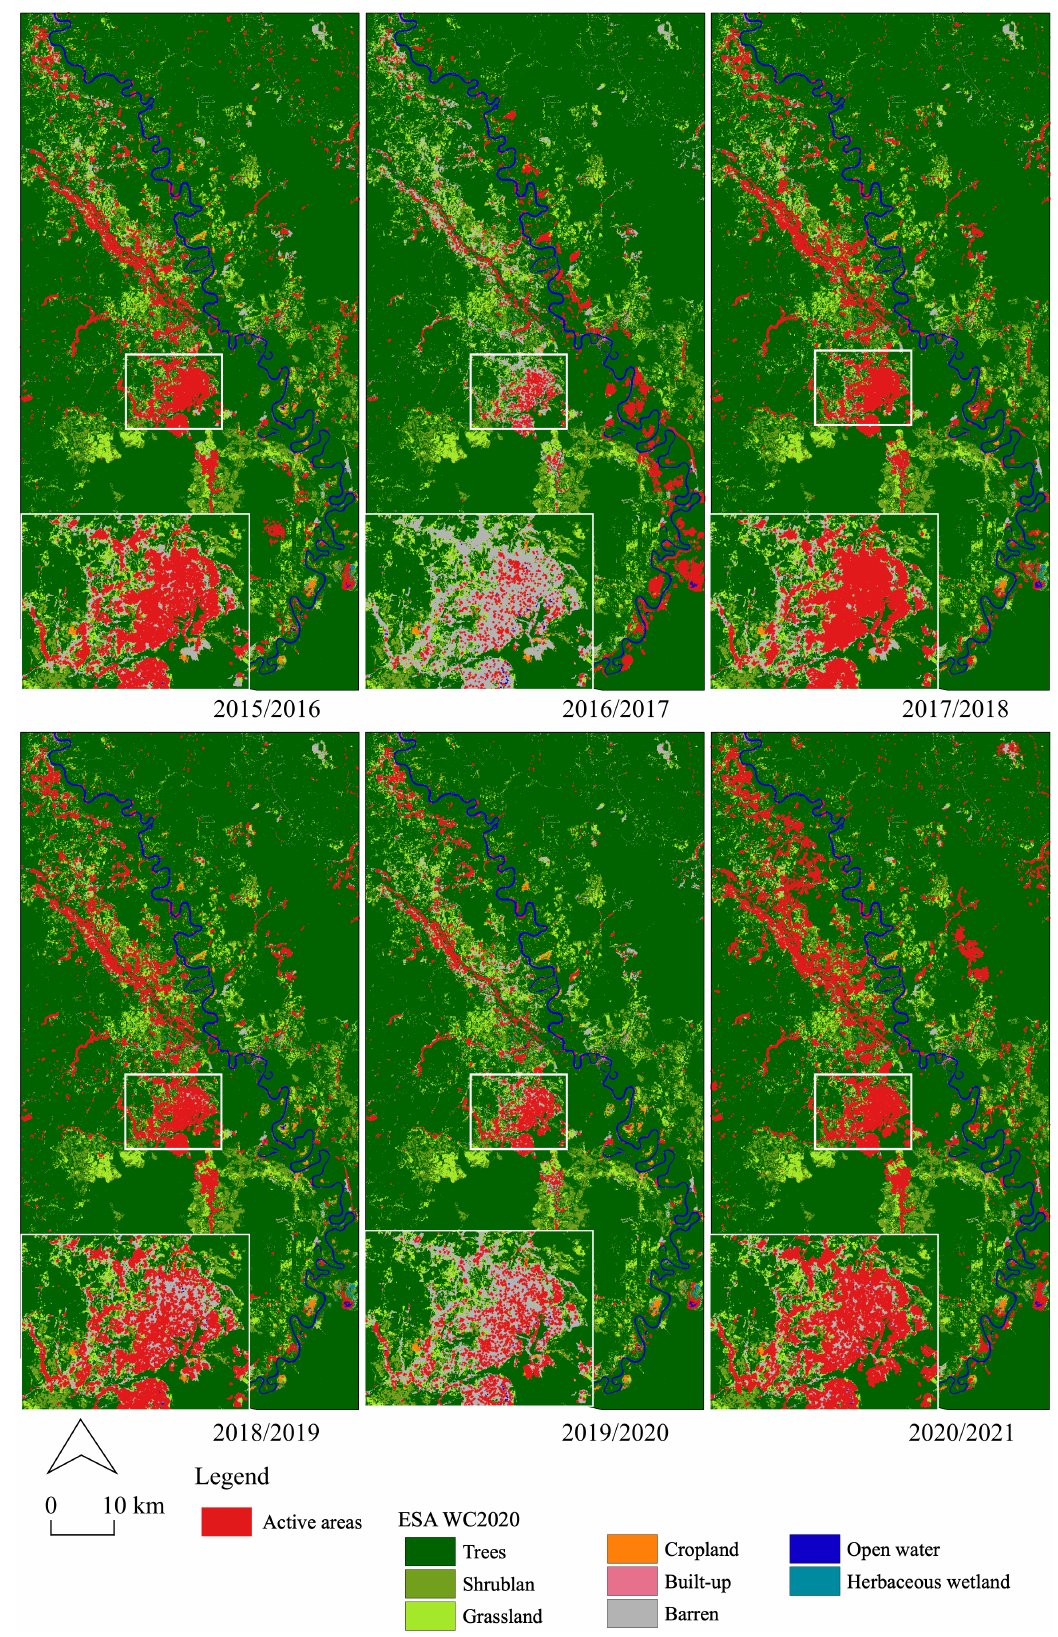
Figure 5. Occurrence of active mining sites detected by VH polarizations and their overlay on the ESA